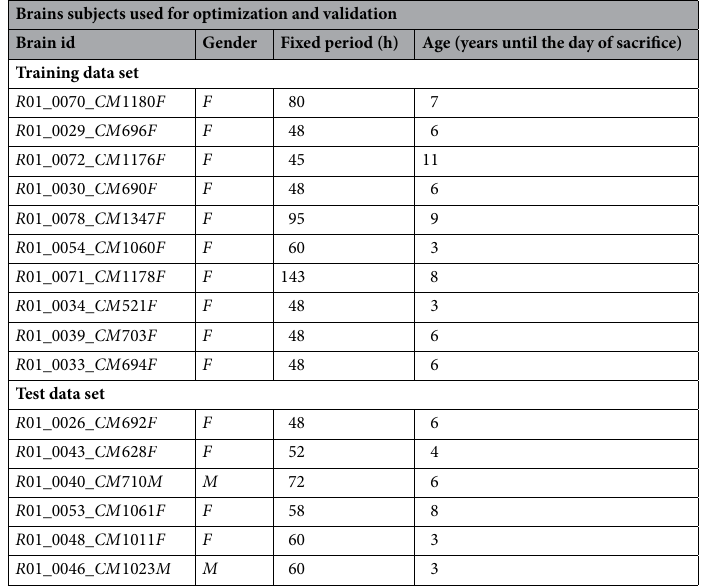
Table 2. Characteristics of marmoset brains used in this study. The same brains were handled for tracer injections and dMRI